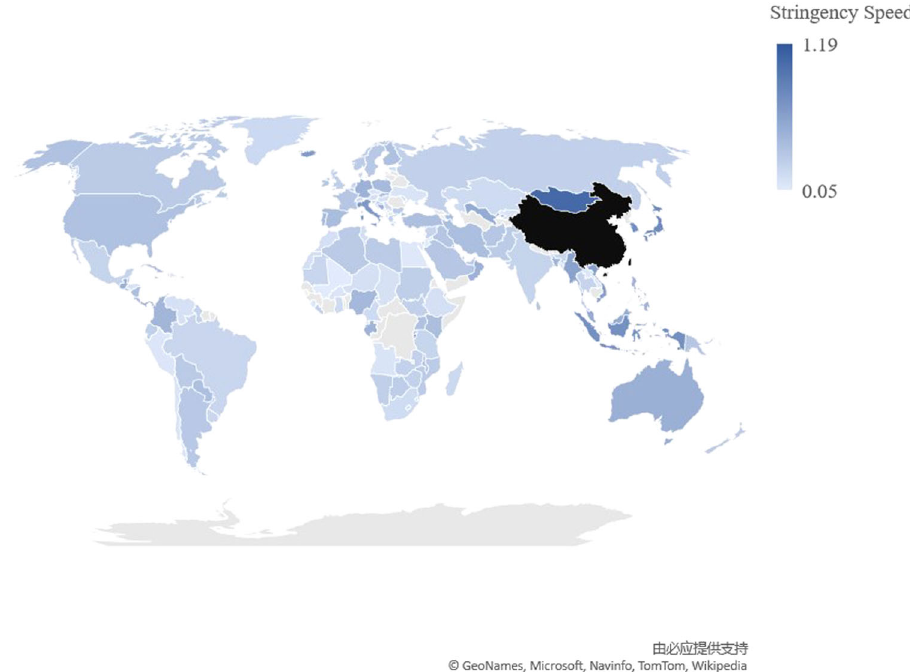
Fig. 1 Stringency speed around the